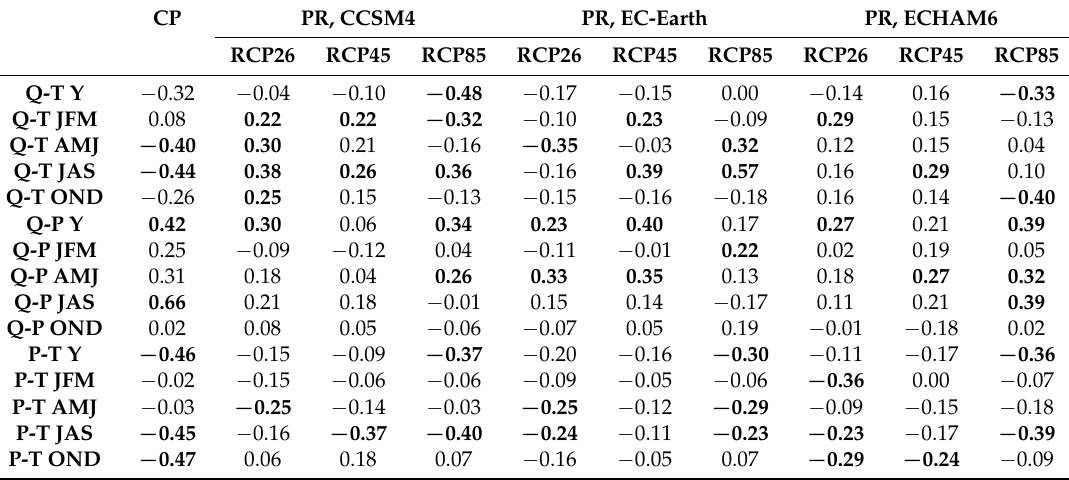
Table 5. Yearly, and seasonal correlation analysis of climate (temperature T, precipitation P), and hydrological (discharge Q) variables, CP, and PR periods (RCP2.6–8.5). In bold significant values ( α =